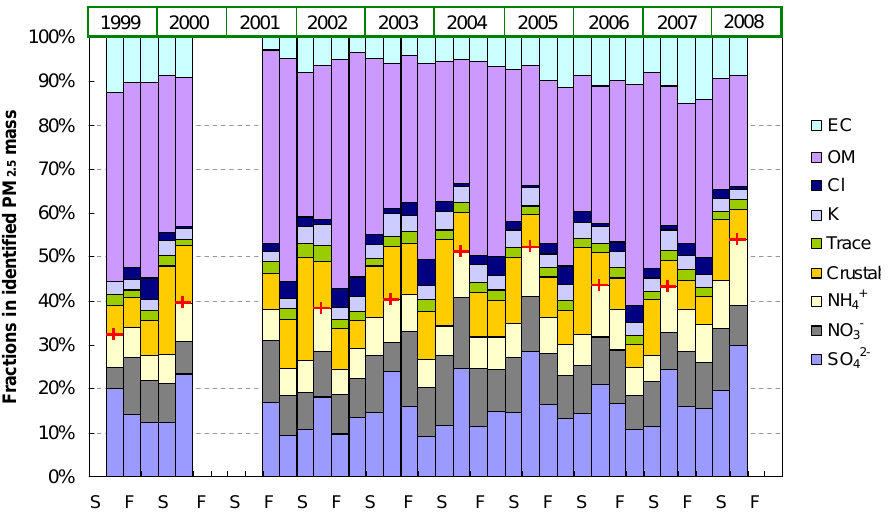
Fig. 5. Seasonal PM 2 . 5 speciation abundances at TH in Beijing from the summer of 1999 through the summer of 2008. Sampling years and seasons (“S” means spring and “F” means fall) are indicated. Average percentages of SNA in each summer are marked with cross symbols.